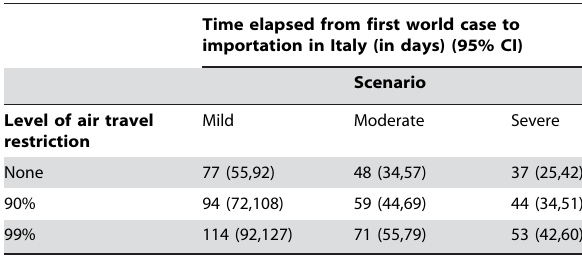
Table 3. Interval (in days) from the first world case to the importation of the first case in Italy, by scenario and level of international air travel restriction.